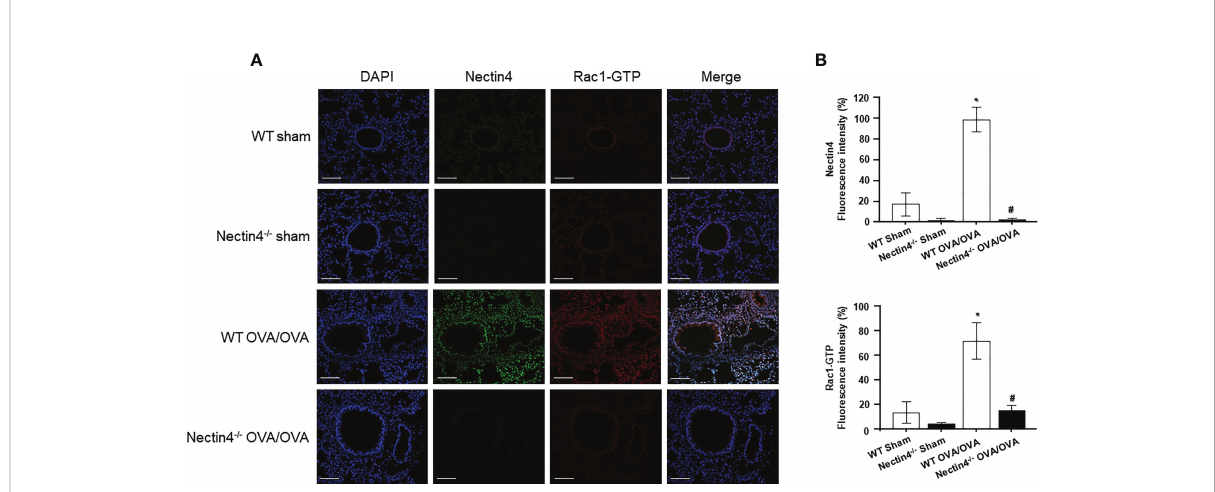
FIGURE 7 Double-staining immuno fl uorescence of Nectin4 (Green) and Rac1-GTP (Red) in ovalbumin-induced asthma model of WT and Nectin4 -/- mice lung. (A) Representative immuno fl uorescence images of Nectin4 and Rac1-GTP in lung of the mice (scale bar = 100 m m). (B) Quantitation of the fl uorescence intensity of Nectin4 and Rac1-GTP. * p<0.05 vs. WT sham. #p<0.05 vs. WT